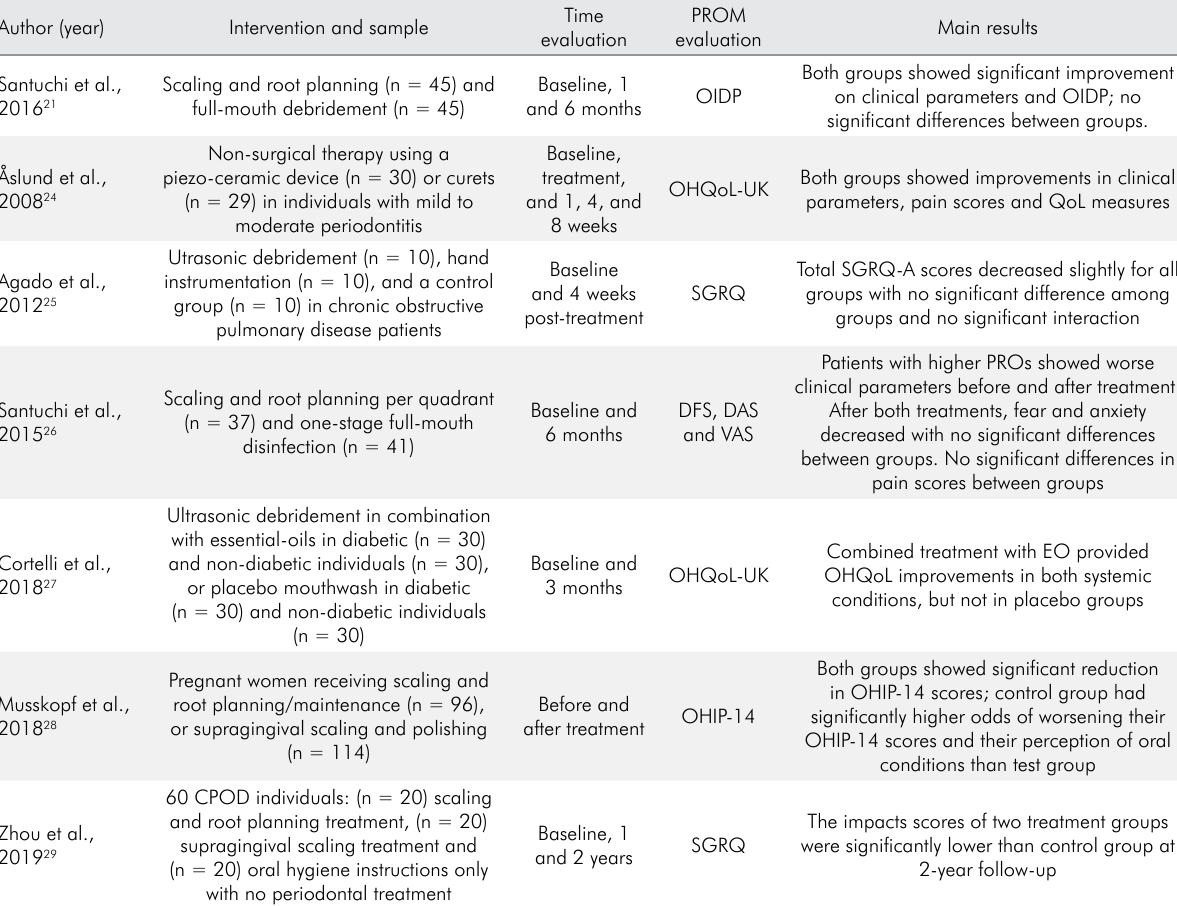
Table 1. Summary of randomized clinical trials that evaluated PROMs. Author